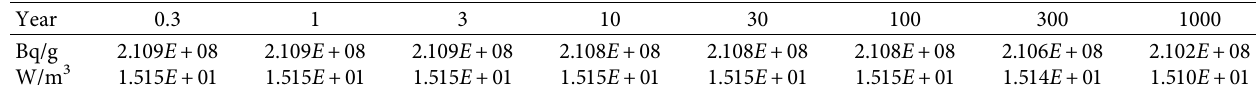
5 Re 2 O 12 waste/waste